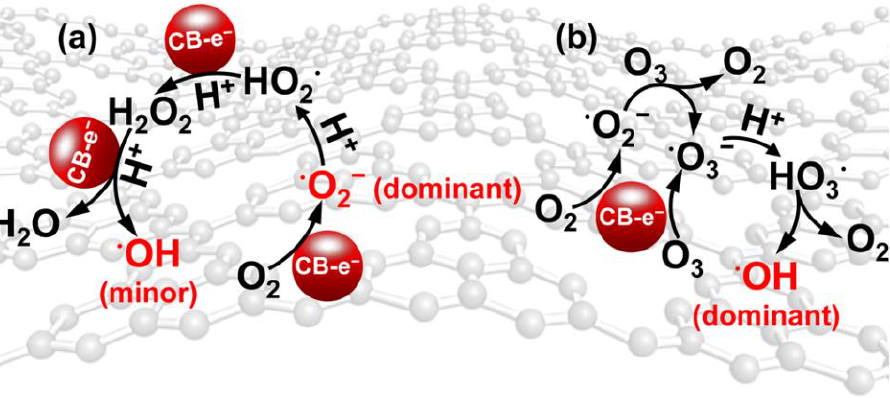
Figure 9. ROS formation pathways in ( a ) Vis/O 2 /C 3 N 4 and ( b ) Vis/O 3 /C 3 N 4 . Reproduced with per- mission from ref. [59]. Copyright 2017 American Chemical Society. permission from Ref. [59]. Copyright 2017 American Chemical